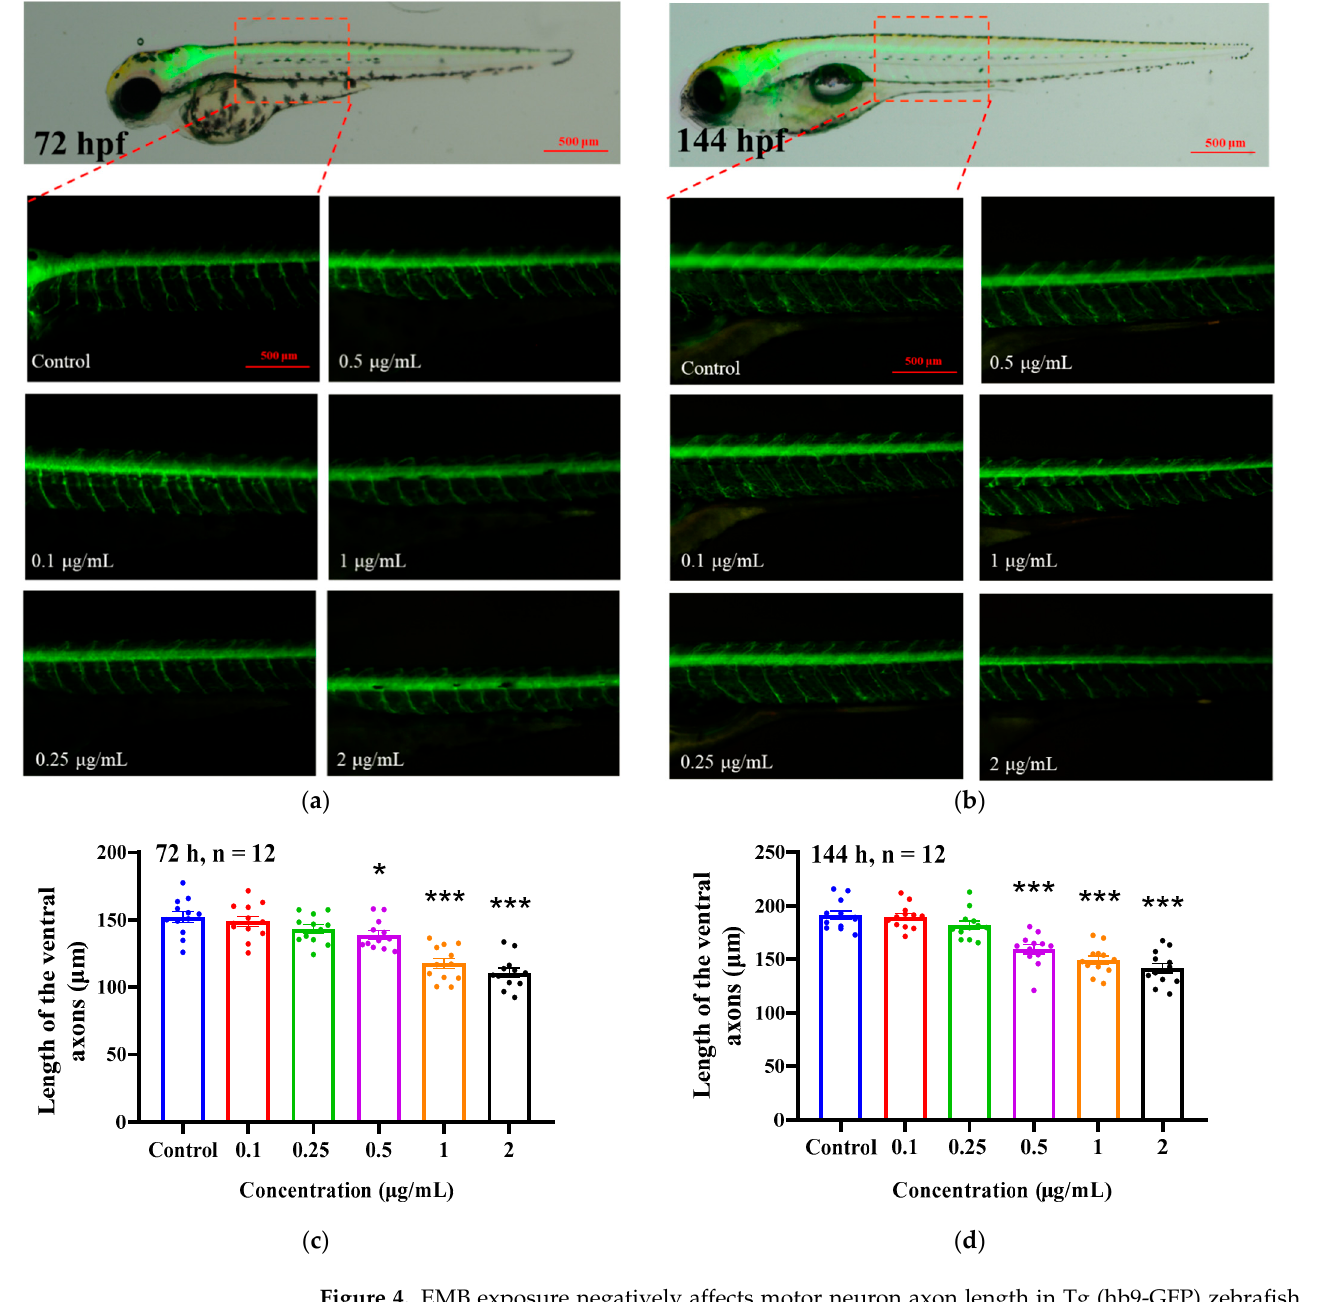
Figure 4. EMB exposure negatively affects motor neuron axon length in Tg (hb9-GFP) zebrafish. Green fluorescence images of motor neuron axon length in Tg (hb9-GFP) zebrafish at 72 and 144 hpf ( a , b ) and fluorescence statistics ( c , d ) ( n = 12 in each group). * p < 0.05, *** p < 0.001, compared with control groups.